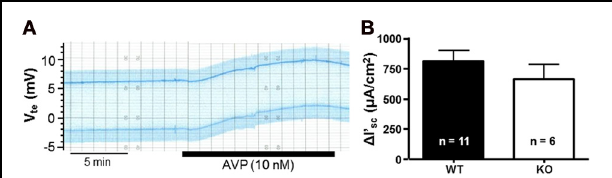
FIGURE 5 | AVP-stimulated NaCl transport increases in P2Y 2 receptor WT and KO mTALs. (A) An original recording of the AVP-induced (10nM) NaCl transport stimulation, in a P2Y 2 receptor WT mouse mTAL. (B) AVP-stimulated NaCl transport was studied in P2Y 2 receptor WT ( n =